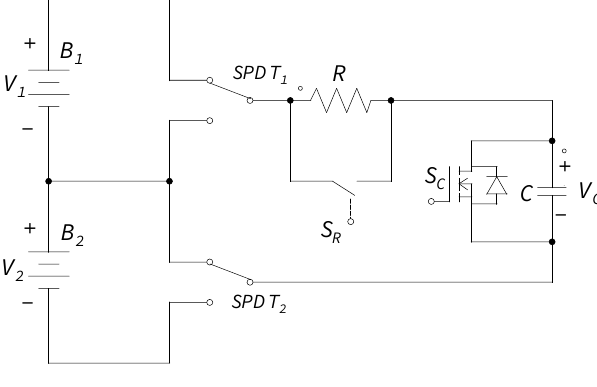
Figure 3. The proposed RC-based battery equalizer.